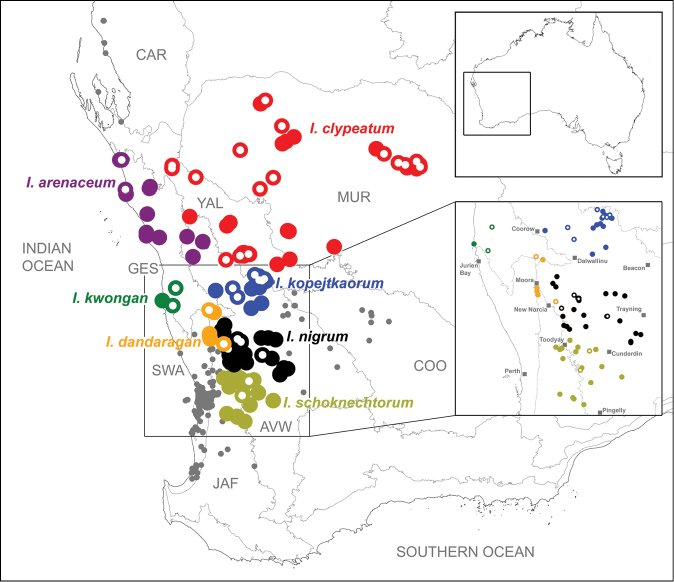
Map showing collection records of Idiosoma species in the ‘sigillate complex’ from south-western Australia; base map shows collection records for all other species in the nigrum-group as smaller grey dots. Lower inset shows detailed collection records for I.
nigrum and other southern taxa, along with select metropolitan centres. Specimens sequenced for the molecular analyses are denoted by open circles, and relevant IBRA 7.0 bioregions are as follows: AVW, Avon Wheatbelt; CAR, Carnarvon; COO, Coolgardie; GES, Geraldton Sandplains; JAF, Jarrah Forest; MUR, Murchison; SWA, Swan Coastal Plain; YAL, Yalgoo.